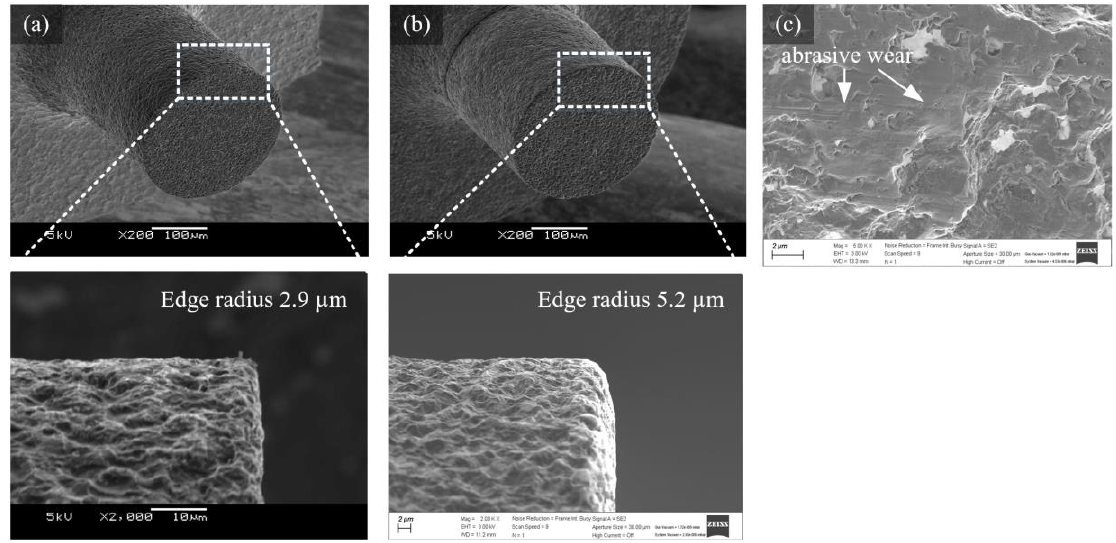
Figure 11. SEM images of a tool edge ( a ) before and ( b ) after machining and ( c ) abrasive wear on the tool’s bottom surface.